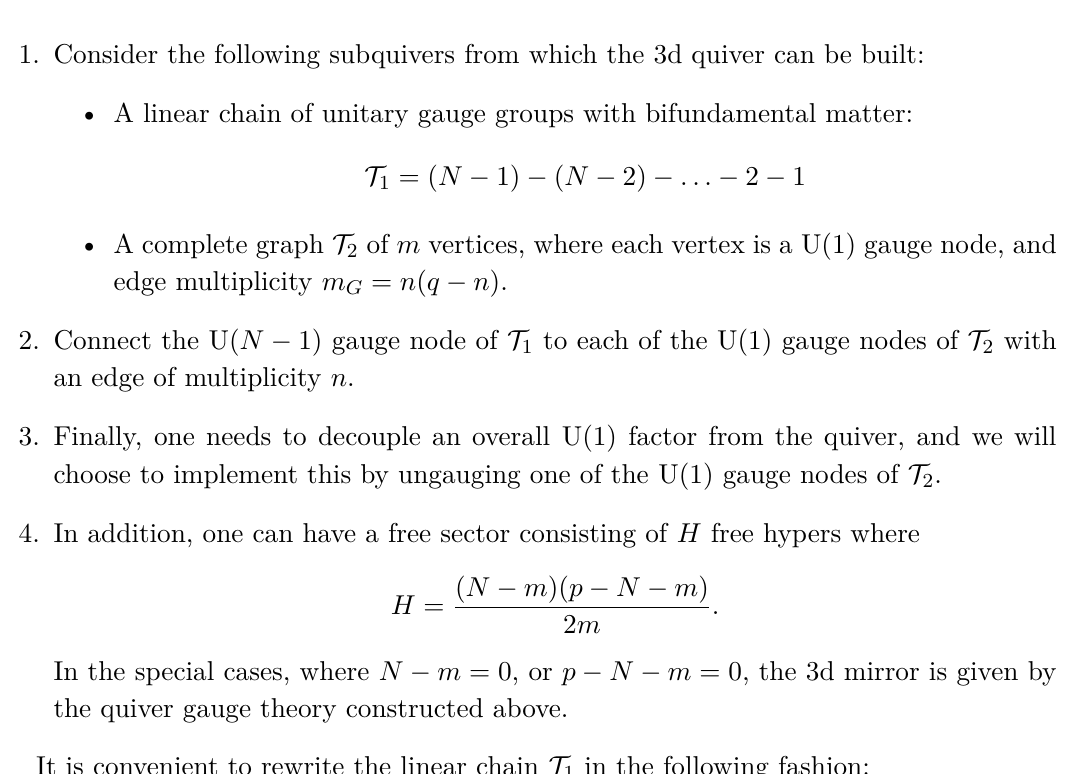
Figure 10 . The 3d mirror for the D p (SU( N )) ( p > N ) AD theory reduced on a circle, for the case m = GCD ( p, N ) = 4 . The quiver on the right is obtained by decoupling a U(1) vector multiplet associated with one of the vertices of the complete graph from the quiver on the left. The multiplicity of the edges connecting U( N − 1) with the U(1) nodes is n , and that of the edges connecting two U(1) nodes is m = n ( q − n ) G